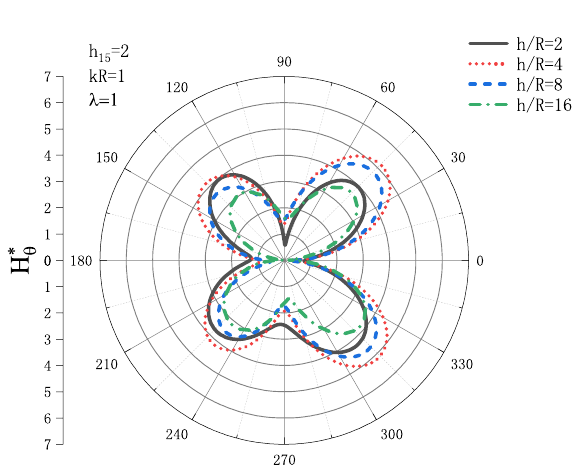
h R when incident frequency kR = 0.1 (cid:31)